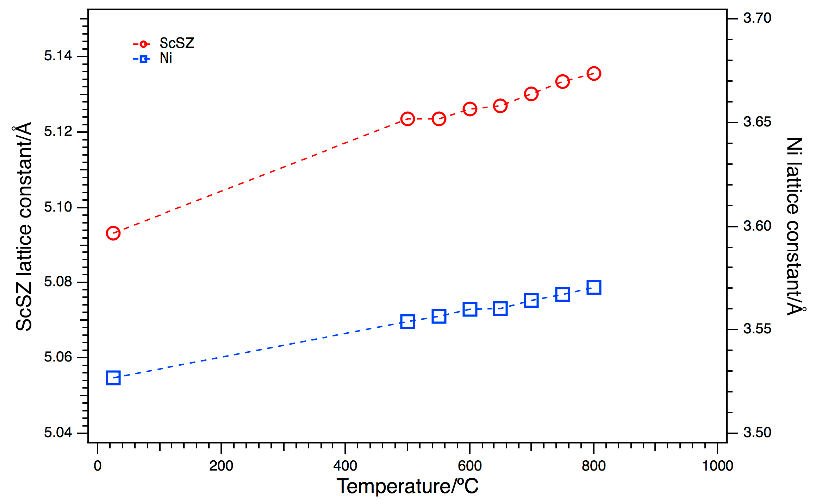
Figure 8. Lattice constant change during the high-temperature XRD analysis of Ni/ScSZ at 500–800 °C.